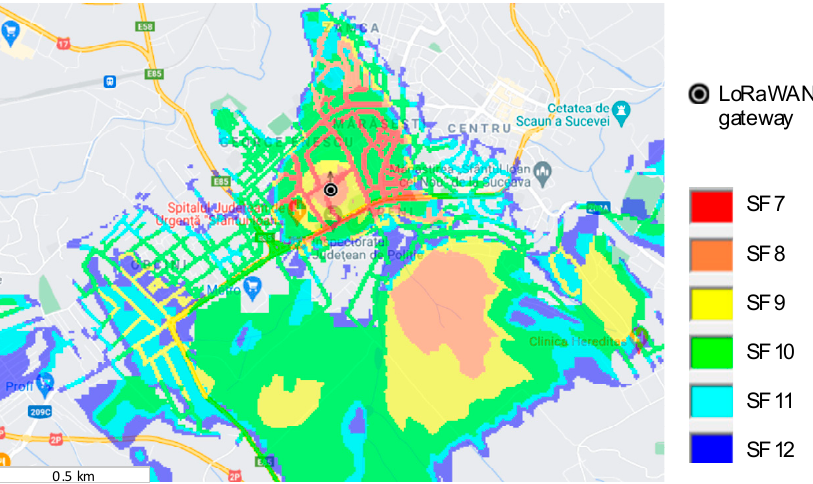
Figure 8. LoRaWAN coverage map simulation using RadioPlanner.